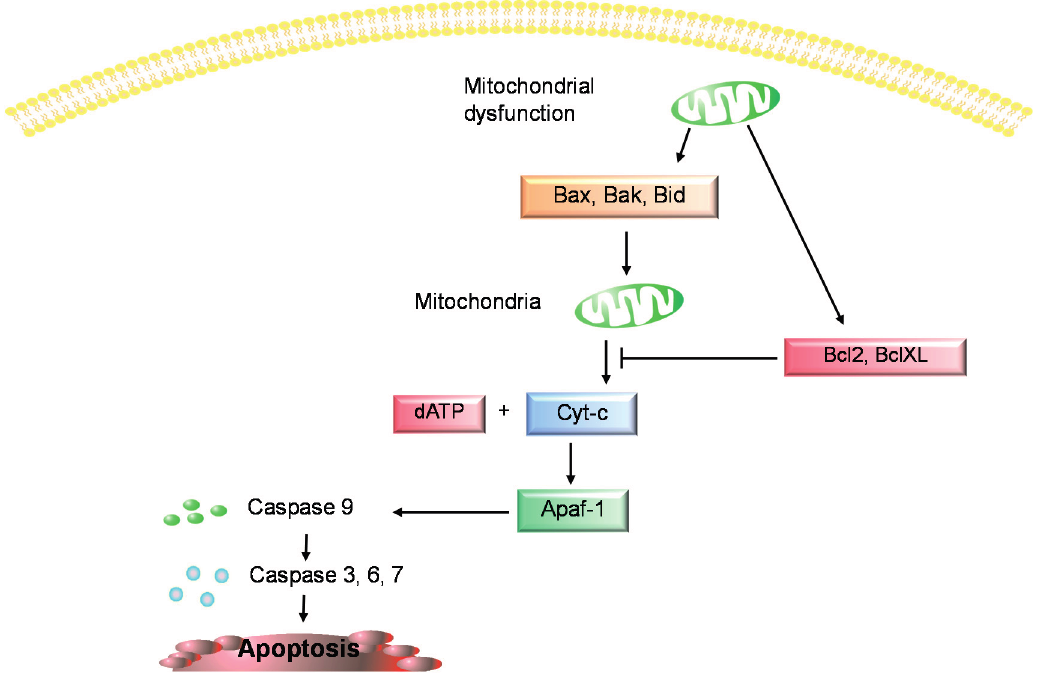
Figure 1. The intrinsic pathway of apoptosis. Bcl-2: B-cell lymphoma-2; Bcl-XL: B-cell lymphoma-XL; Bax: Bcl-2-associated X protein; Bak: Bcl-2 homologous antagonist/killer; Bid: BH3 interacting domain death agonist; dATP: deoxyadenosine triphosphate; Apaf-1: apoptotic protease activating